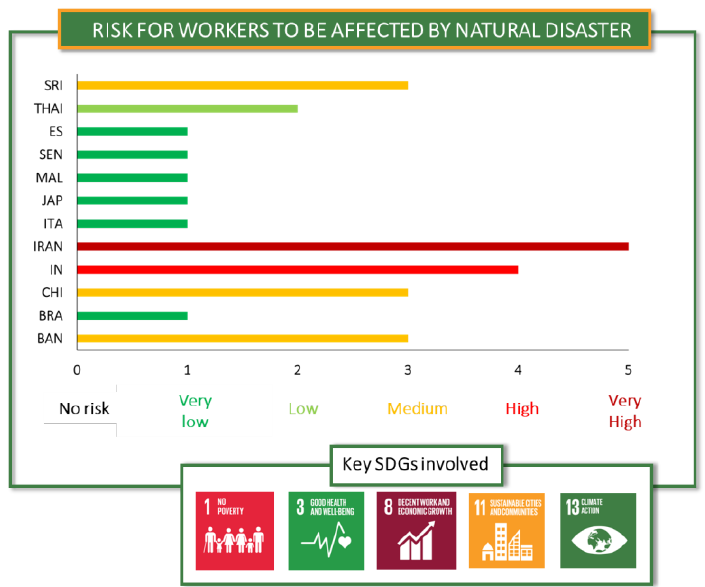
Figure 8. Health and safety: Risk for workers to be affected by natural disasters [73].